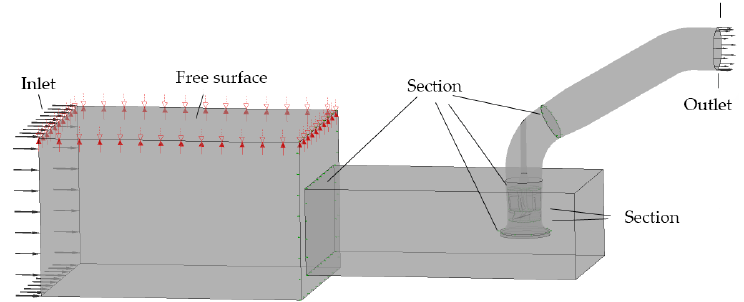
Figure 3. 3D model of pump system. Figure 3. 3 D model of pump system.